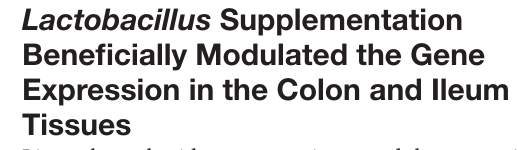
of IL-22 and IL-10 were higher in LAB3-, LAB8-,